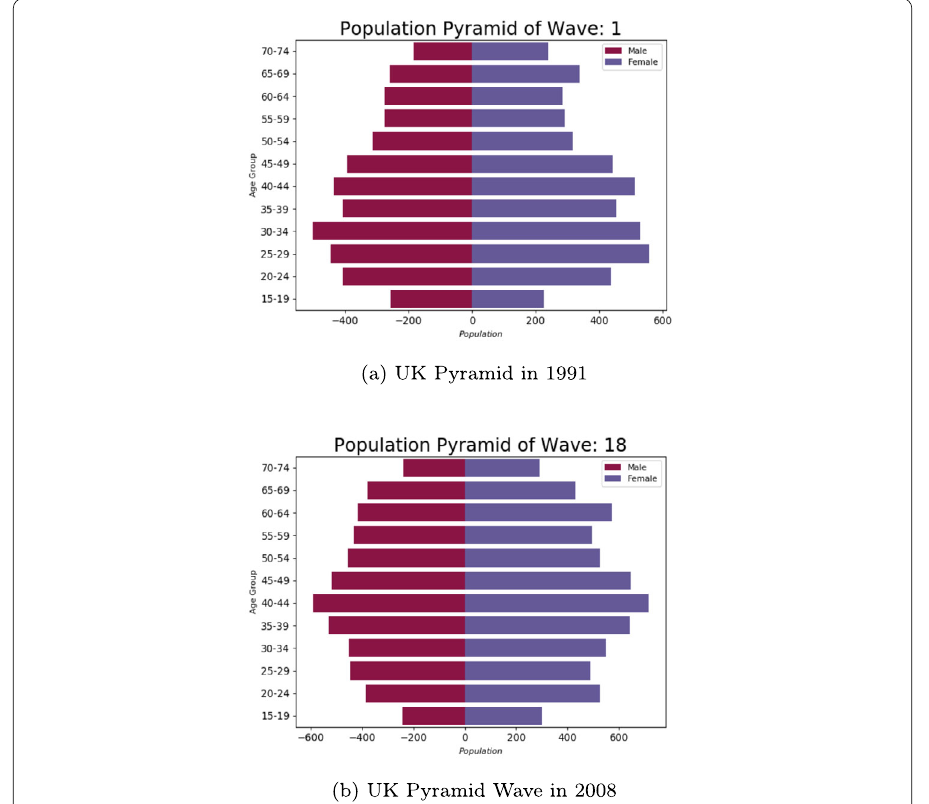
Figure 2 Population Pyramid for the UK Income between Ages 15–100 reflecting changes of age distribution in 18 years, which reflects mostly an aging